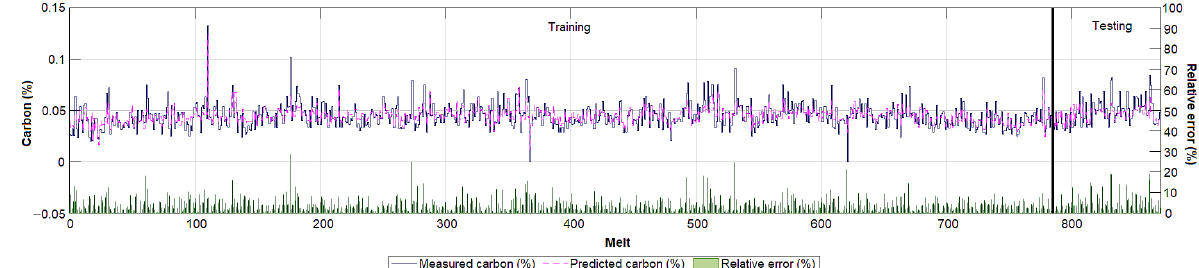
Figure 16. Prediction of endpoint carbon concentration in melt by piecewise-cubic MARS